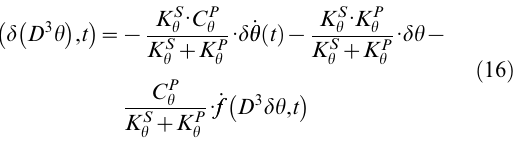
Figure 2c represents a non-linear system known in the engineering literature as the Duffing model. It provides an approximation of a tendon’s slack behavior. Here, the stiffness depends on position, and is low for small displacements (slacking of the tendon) and increases abruptly after a fixed threshold. As a first approximation the stiffness of the model is considered to increase cubically (hardening system) which is compatible with experimen- tal evidence found in human triceps surae muscle [42]. In general, Duffing type models can generate chaotic responses; however, we will restrict our study to a system with known stable behavior. In the time domain, Duffing viscoelastic force can be expressed using the differential equation [43,44]: